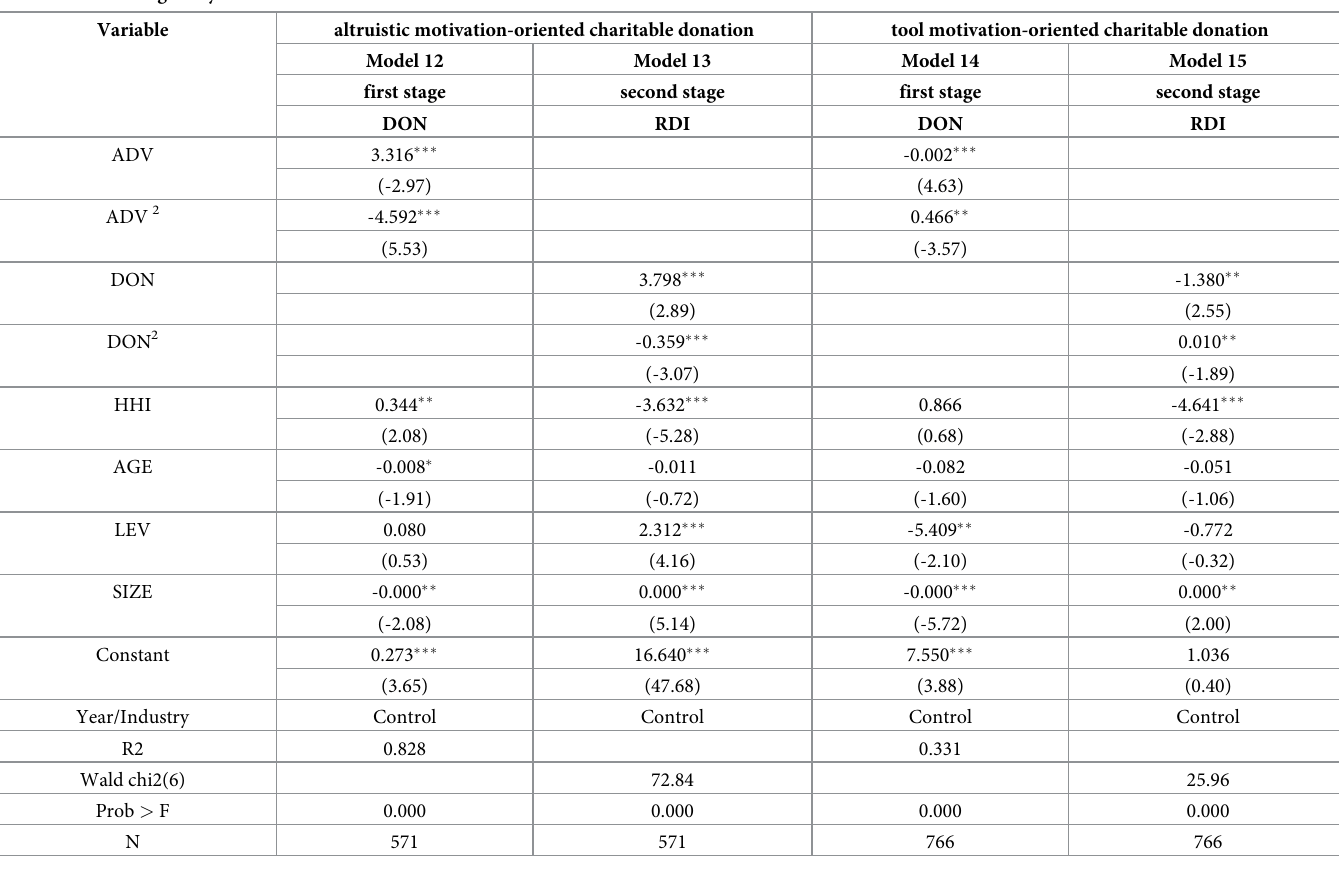
Table 7. 2SLS endogeneity